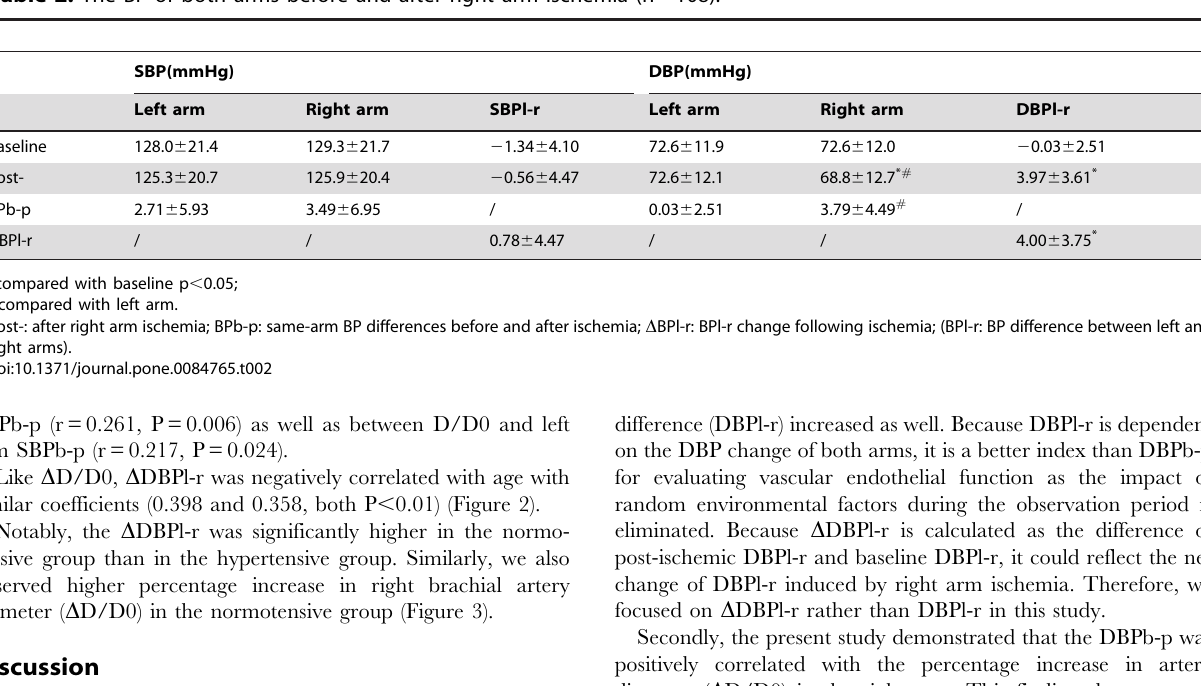
Table 2. The BP of both arms before and after right arm ischemia (n=108).